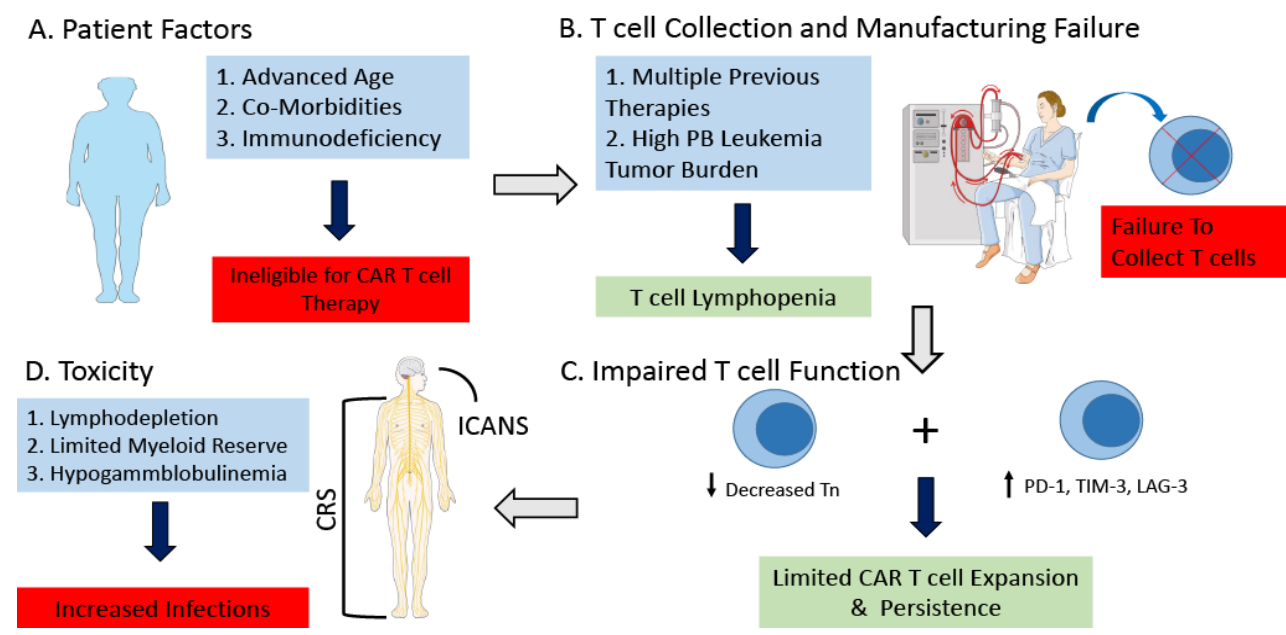
Figure 1. Challenges of CAR T cell Therapy for Patients with CLL. Challenges of CAR T cell therapy for patients with CLL include ( A ) Patient dependent comorbidities and immunodeficiency which can make patients ineligible for CAR T cell therapy. ( B ) Previous treatment as well as high leukemia cell burden can lead to peripheral blood T cell lymphopenia ultimately resulting in a failure to collect a satisfactory amount of T cells in order to manufacture the CAR T cell product. ( C ) Immunosubversion of the CAR T cell product from patients with CLL. T cells from patients with CLL exhibit an exhausted phenotype, characterized by increased expression of PD-1, TIM-3, and LAG-3. There is decreased naïve T cells, with significant functional defects of CD8+ T cells resulting in decreased proliferation and cytotoxicity. ( D ) Patients with CLL may be at increased risk of toxicity related to CAR T cell therapy, secondary to underlying immunosuppression, age, and co-morbidities. Abbreviations: Chronic Lymphocytic Leukemia (CLL); Peripheral Blood (PB); Naïve T cells (Tn); Programmed cell death protein 1 (PD-1); T cell immunoglobulin and mucin-domain containing-3 (TIM-3); Lymphocyte Activation Gene 3 (LAG-3); Cytokine Release Syndrome (CRS); Immune Effector cell-associated neurotoxicity syndrome (ICANS). This figure was created with images adapted from Servier Medical Art by Servier. Original images are licensed under a Creative Commons Attribution